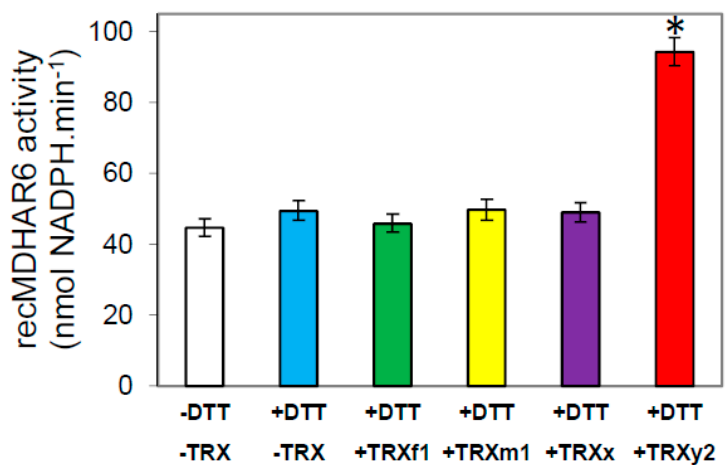
Figure 8. Effect of reducing treatments on AtMDHAR6 activity. A sample of purified recombinant AtMDHAR6 enzyme was incubated for 15 min at room temperature prior to measuring its NADPH-dependent activity. Incubation was in absence of DTT (white bar), or in presence of DTT, alone (blue bar), or with TRX: f1 (green bar), or m1 (yellow bar), or x (purple bar), or y2 (red bar). Data correspond to means ± SD ( n = 4, from 2 independent experiments). The treatment significantly increasing NADPH-MDHAR activity (comparison with untreated) ( p < 0.05) is indicated by an asterisk (*).